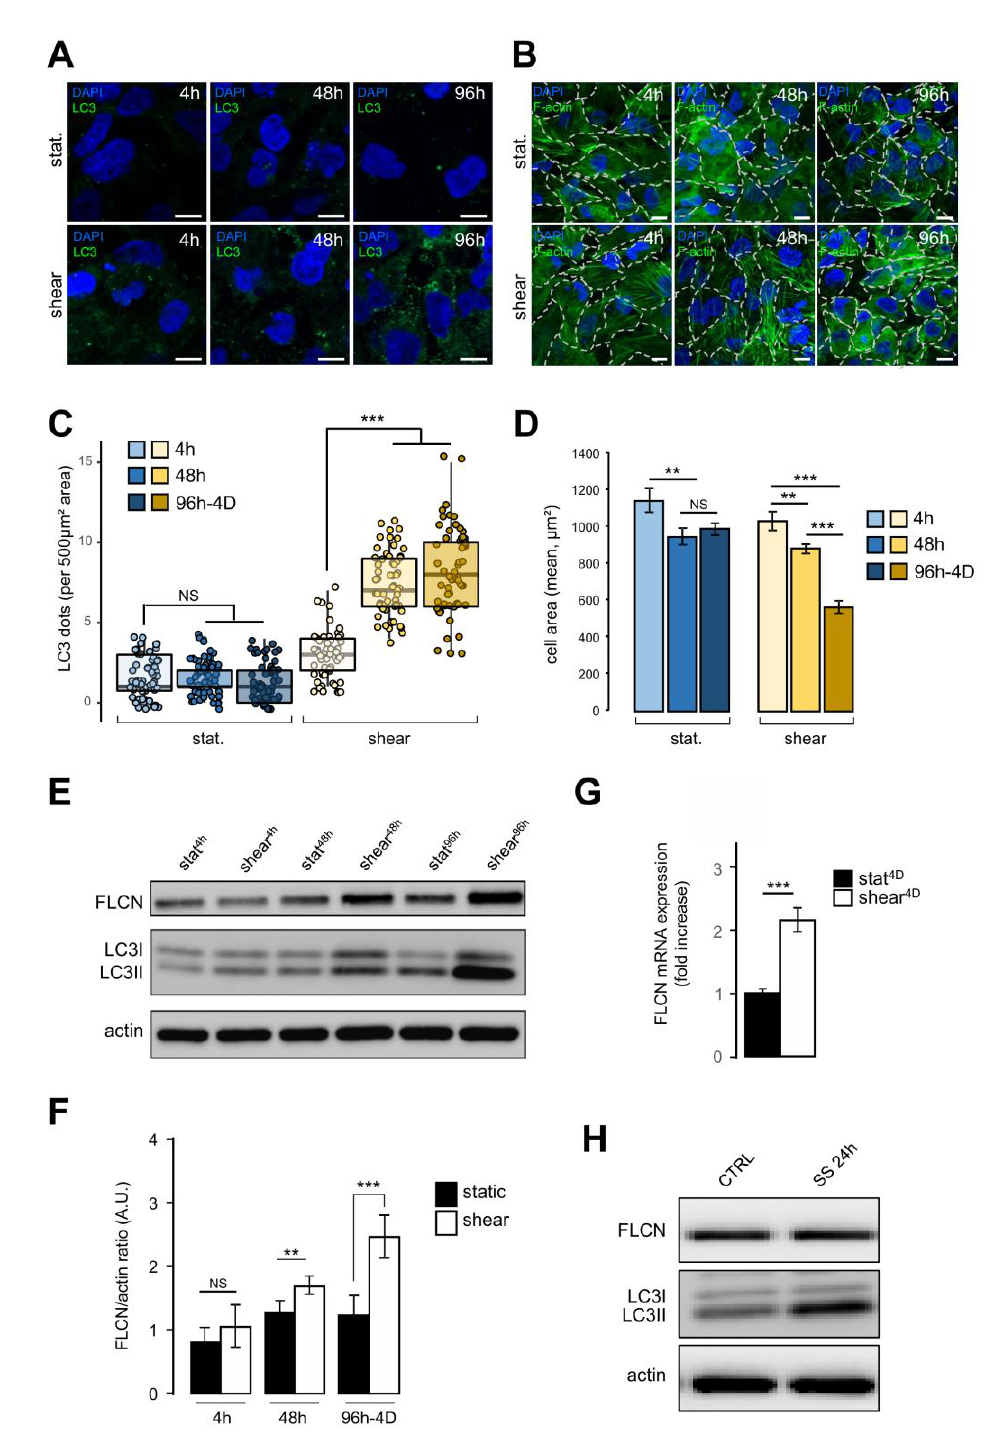
FIGURE 1: Shear stress induces autophagy, cell size decrease and FLCN expression. (A-D) HK2 cells were subjected to fluid flow from 4 h to 4 days (shear 4 h, 48 h, 96h-4D), or not (static 4 h, 48 h, 96h-4D). (A) After fluid flow treatment or static culture, cells were fixed, labeled with DAPI and immunostained for the autophagosome marker LC3 or stained with phalloidin to reveal F-actin and cell boarders are marked out with white dashes (B) and then analyzed by fluorescence microscopy. (C) Quantification of LC3 puncta (LC3 dots number per 500 μm² area) from experiments shown in (A). (D) Quantification of cell area (mean) from experiments shown in (C). (E-F) HK2 cells were subjected to fluid flow from 4 h to 4 days (shear 4 h, 48 h, 96h-4D), or not (static 4 h, 48 h, 96h-4D). (E) Representative western blot analysis of FLCN, LC3I, LC3II and actin in the indicated conditions. (F) Quantification of Western blot shown in (E). (G) HK2 cells were subjected to 4 days (shear 4D) fluid flow or not (static 4D) and FLCN mRNA ex- pression level was determined and quantified by RT-qPCR. (H) HK2 cells were maintained in normal culture condition (CTRL) or subjected to a 24 h serum starvation (SS 24 h). Levels of the FLCN, LC3I and LC3II were analyzed by western blot. Scale bars in (A) and ( C) =